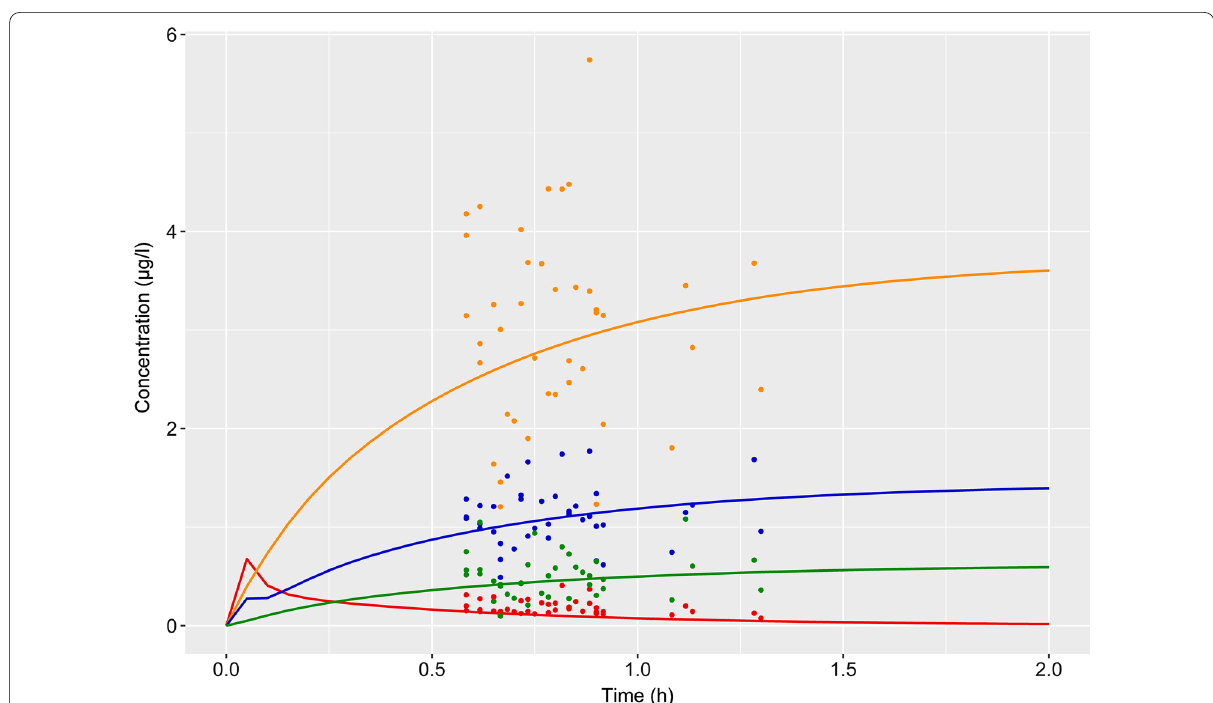
Fig. 2 Simulation curves (lines) and observed clinical data (points) of 68 Ga‑DOTATATE over time with plasma concentrations in blood (red) and organ concentrations for spleen (orange), liver (blue) and thyroid (green)